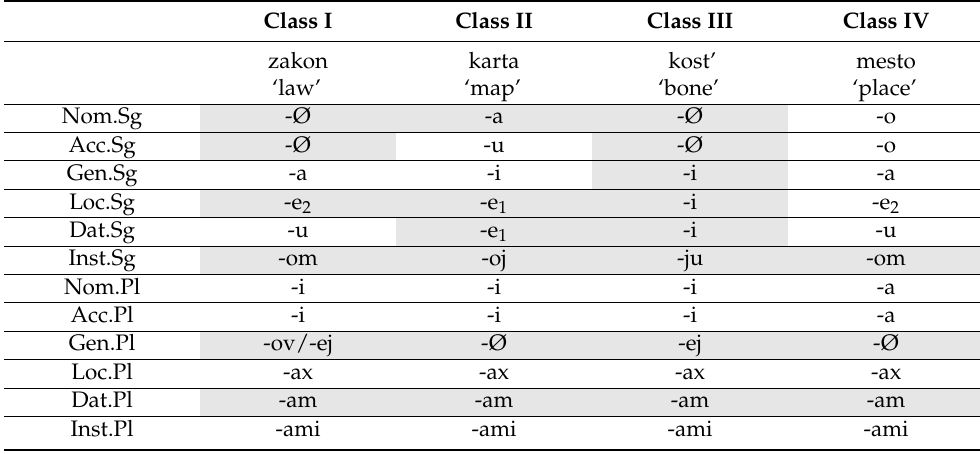
Table 1. Inflectional affixes of Russian nouns. Subscript numbers refer to homophonous singular affixes treated as distinct affixes in the account of Müller (see Section 4.2 below). Highlighted cells represent affixes present in experimental stimuli (see Section 5.2